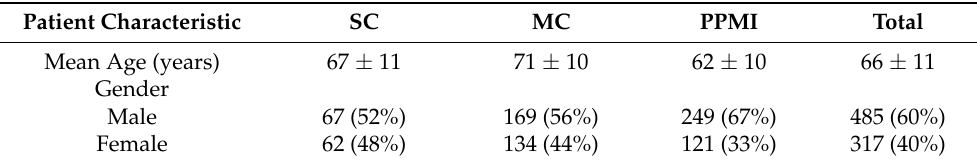
Table 1. Demographic data of the three study groups.